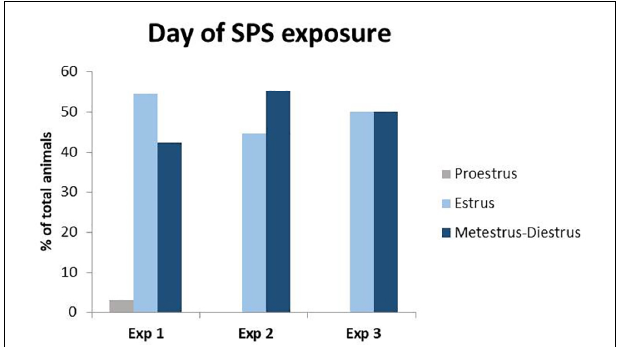
FIGURE 1 | Percent of total animals in each phase of the estrous cycle during Single Prolonged Stress (SPS). Vaginal smears were taken right before the time of SPS in experiments 1–3. Only one animal was in proestrus at the time of SPS in experiment 1 and was excluded from the behavioral analysis to control for fluctuations in estrogen during the proestrus